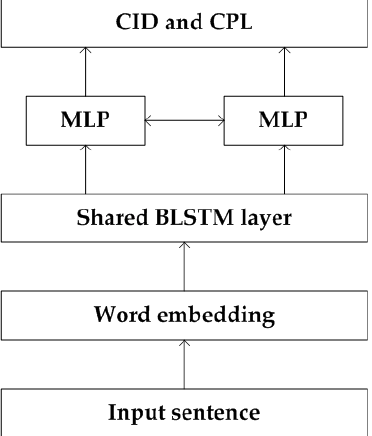
Figure 3. Architecture of the CIU model.